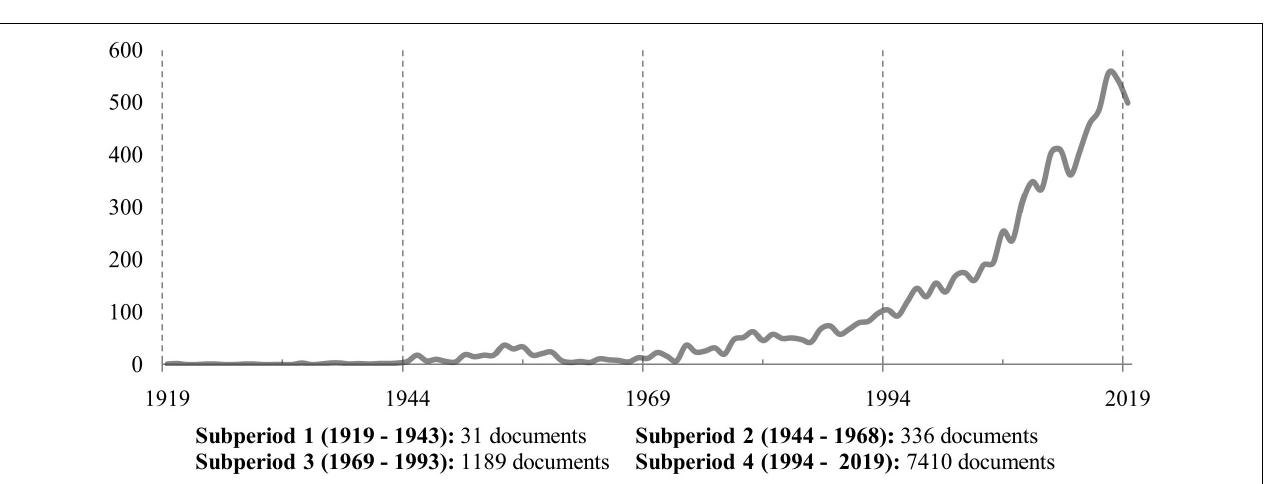
FIGURE 1 | (A) Strategic diagram. (B) Thematic network structure. (C) Thematic evolution structure.